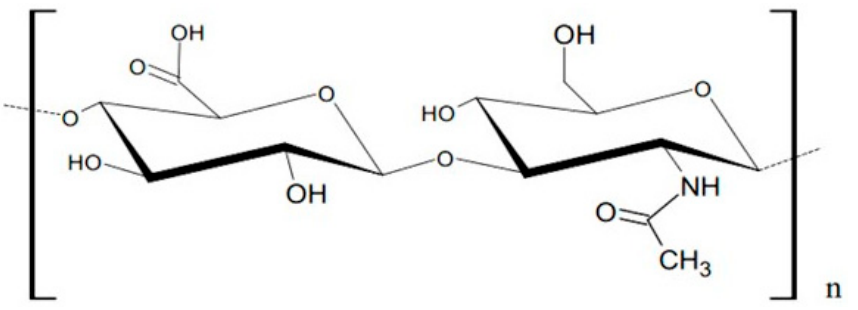
Figure 1. The structure of hyaluronic acid disaccharide.